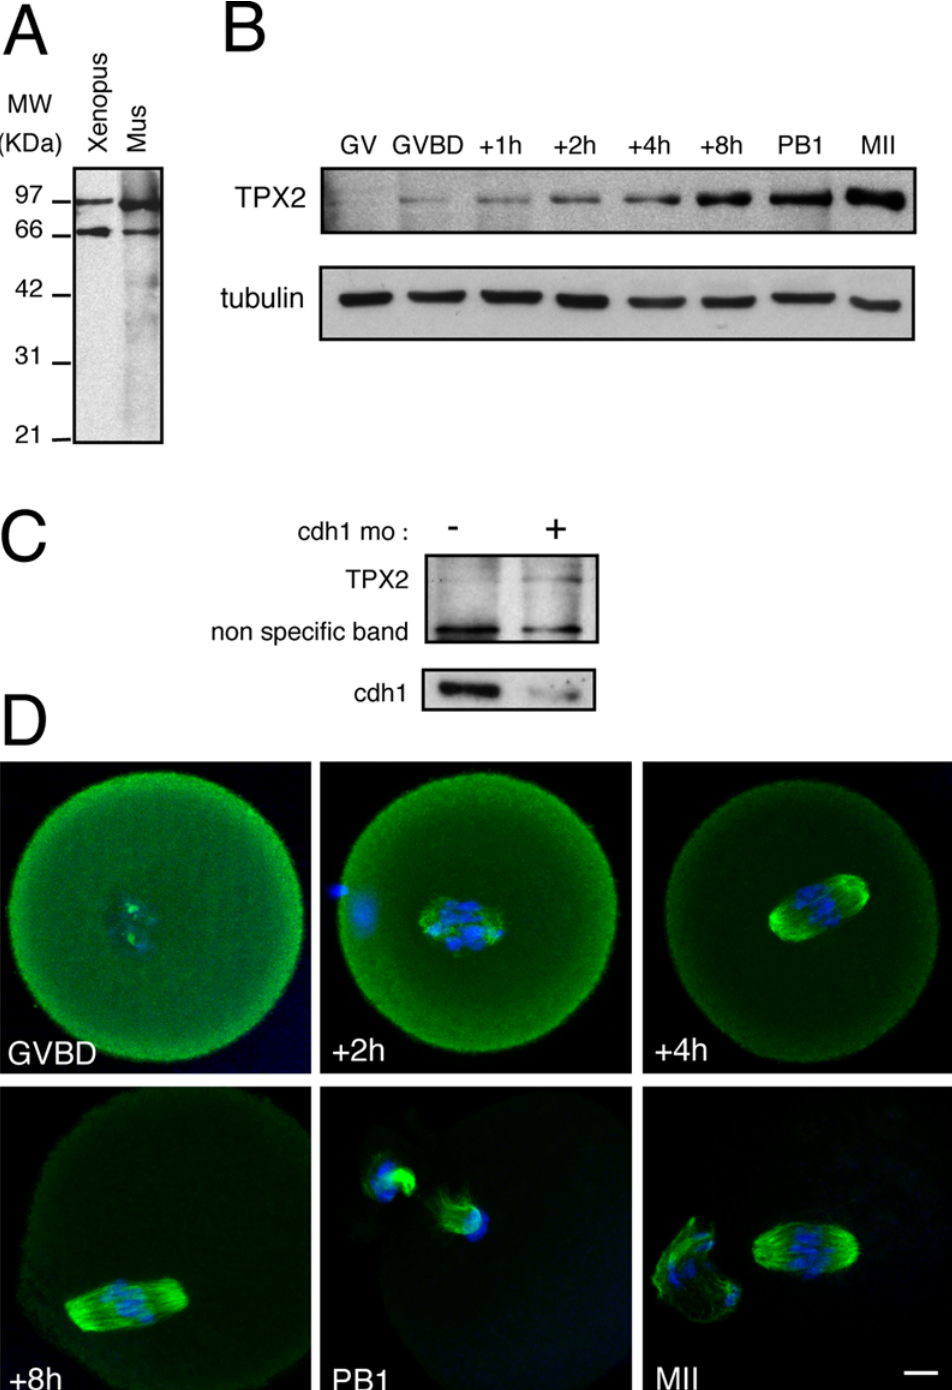
Figure 1. Characterization of TPX2 during mouse oocyte meiotic maturation. A: Mouse oocytes (n=200) and Xenopus metaphase II oocyte lysate (equivalent to 1/4 of oocyte) were immunoblotted using an anti-TPX2 antibody. The upper band corresponds to TPX2. The lower band is non- specific [11]. B: TPX2 accumulates progressively during meiotic maturation. For each time point, 140 mouse oocytes were immunoblotted using anti- TPX2 (only the TPX2 specific band is presented) and anti- a -tubulin antibodies. C: Cdh1 controls TPX2 levels at GV (Prophase I). Western blot analysis of TPX2 and cdh1 in control oocytes and cdh1 morpholino injected oocytes (n=100 for each group). D: Localization of TPX2 during meiotic maturation. Oocytes were double stained for TPX2 (green) and nucleic acids (blue) at the times indicated relative to GVBD. In meiosis I and II, TPX2 decorates the spindle microtubules. Scale bar is 10 m m.